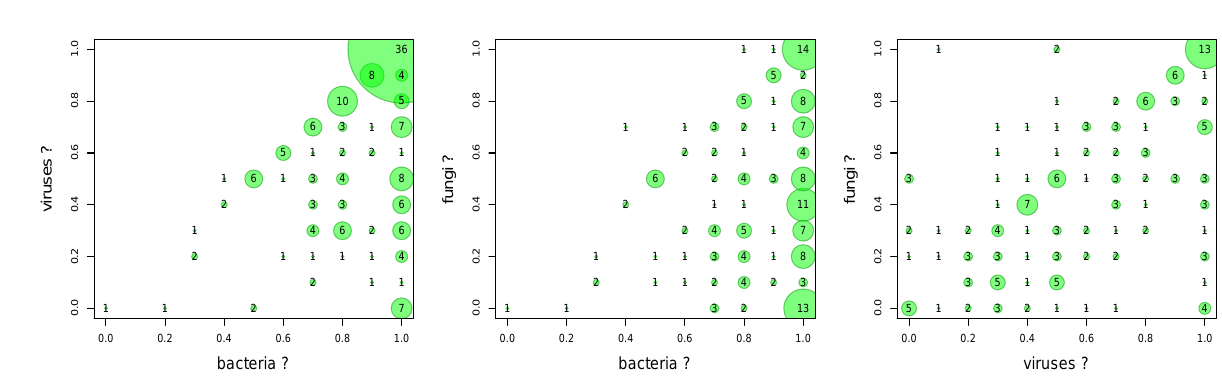
Figure 1. Comparative 2D histogram (“Do you think there are bacteria/viruses/fungi on touch screens?”), 0.0—none, 1.0—a lot of them.